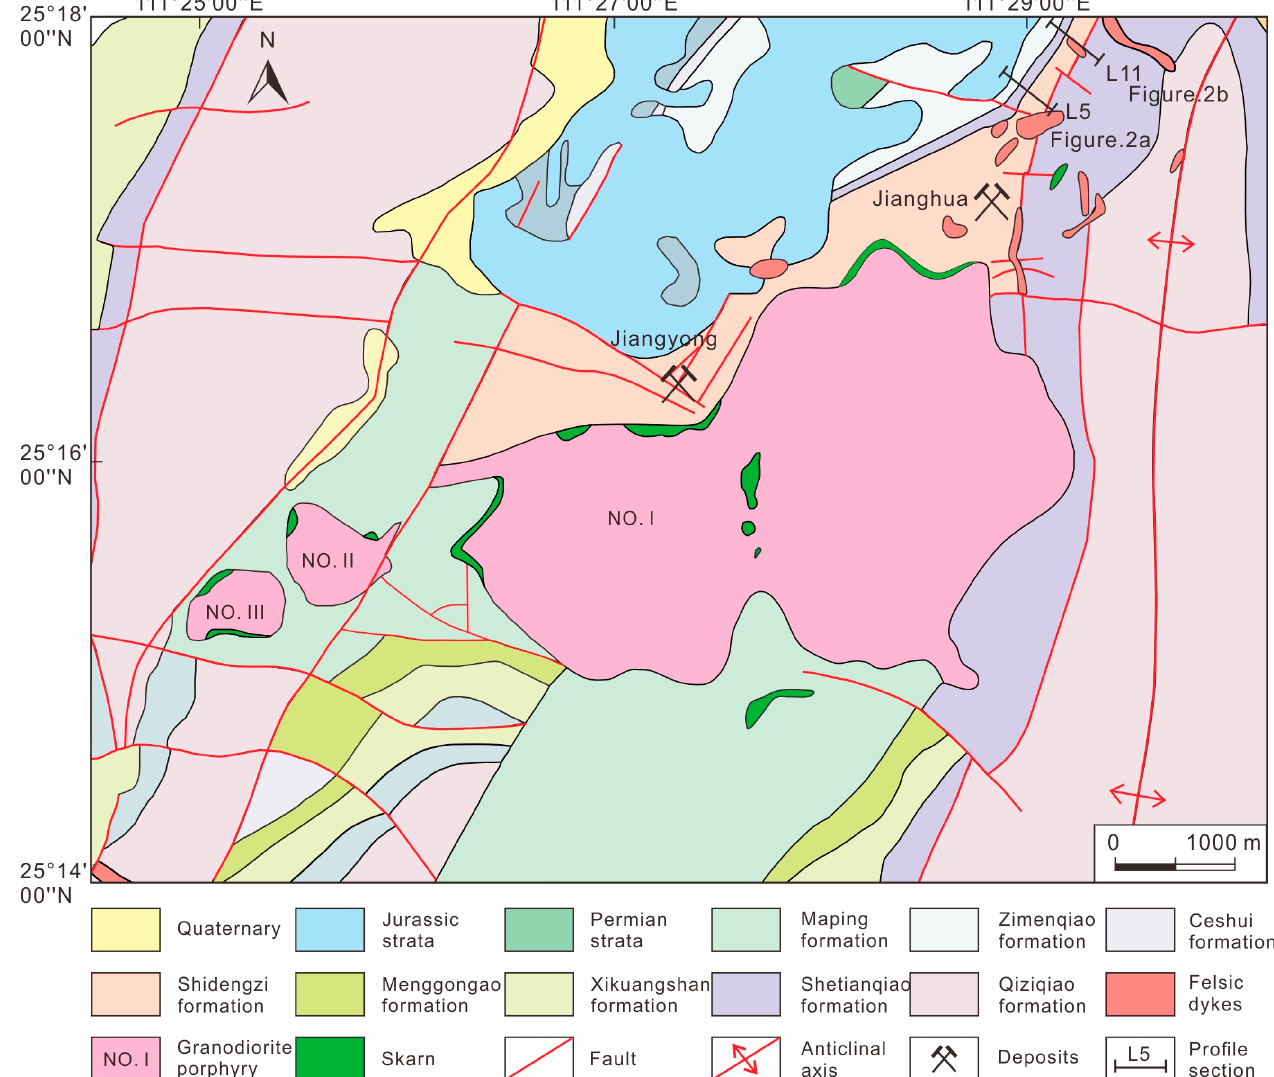
Figure 2. Geological map of the Tongshanling Cu polymetallic ore field, modified from [9].